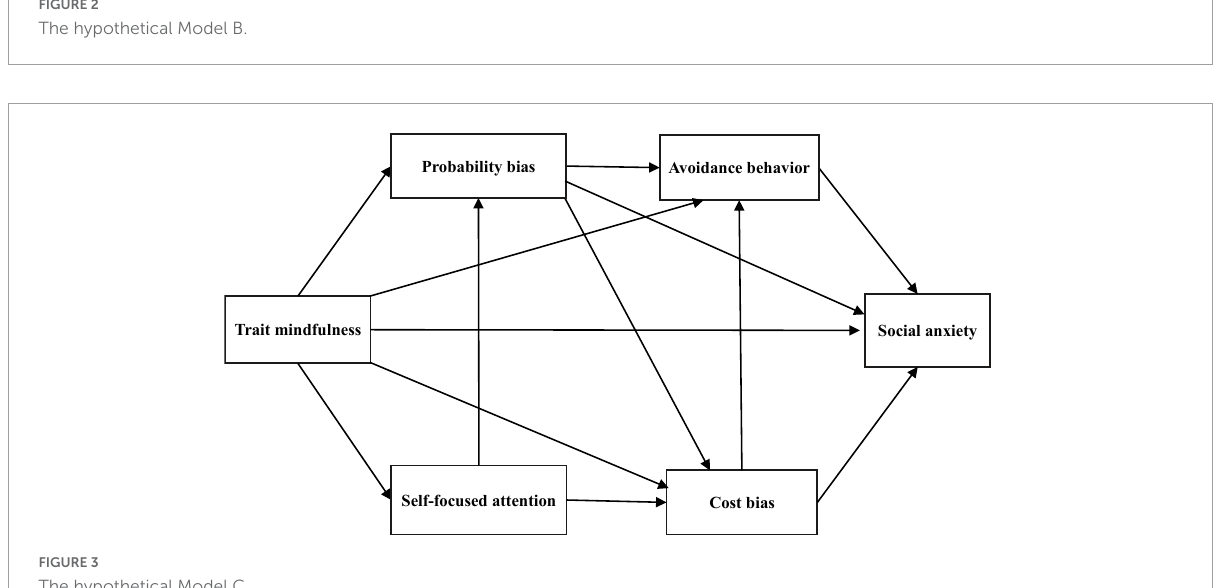
FIGURE2 The hypothetical Model B.